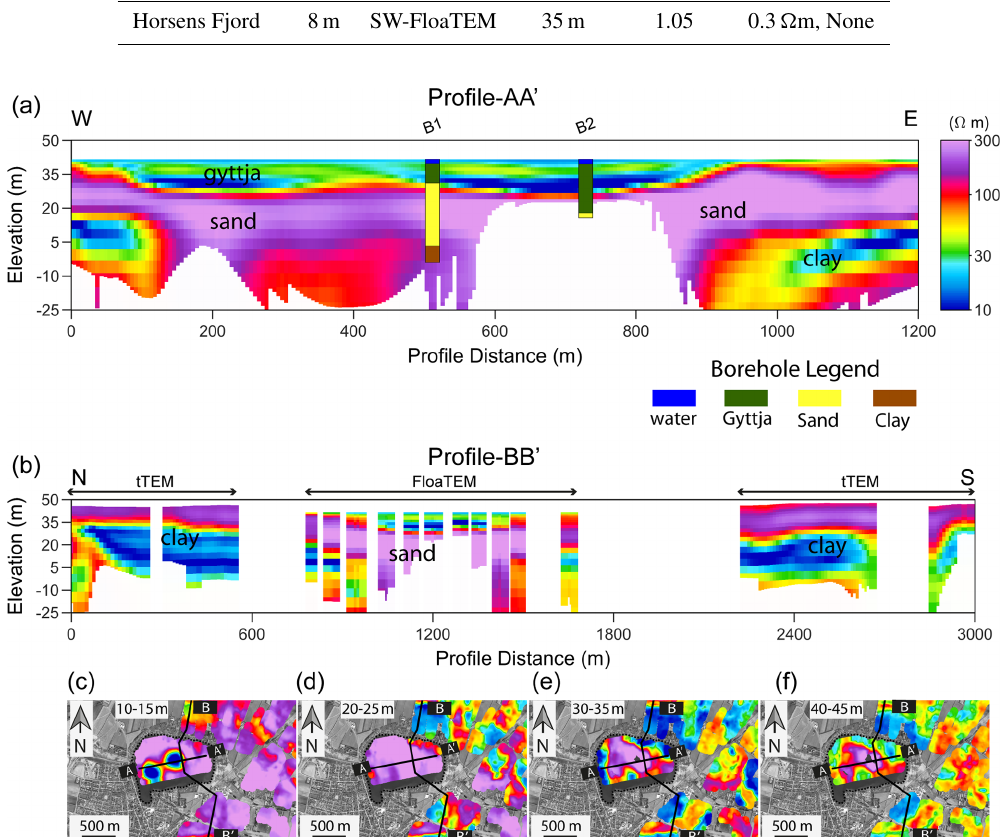
Figure 5. Results from Sunds joint tTEM and FloaTEM survey. Panels (a) and (b) show the resistivity model along profiles AA (cid:48) and BB (cid:48) , respectively; the locations of profiles AA (cid:48) and BB (cid:48) are marked in Fig. 4. Note that while the elevation axis is identical, the profiles have different lengths and thereby different vertical exaggeration. Profile AA (cid:48) includes lithological interpretations from available boreholes near the survey line. Note that the water column is included in the figure but only 2m thick; panels (c) – (f) show mean resistivity maps at various depth intervals with profiles AA (cid:48) and BB (cid:48) indicated as solid black line. Lake Sunds is marked with a dotted black